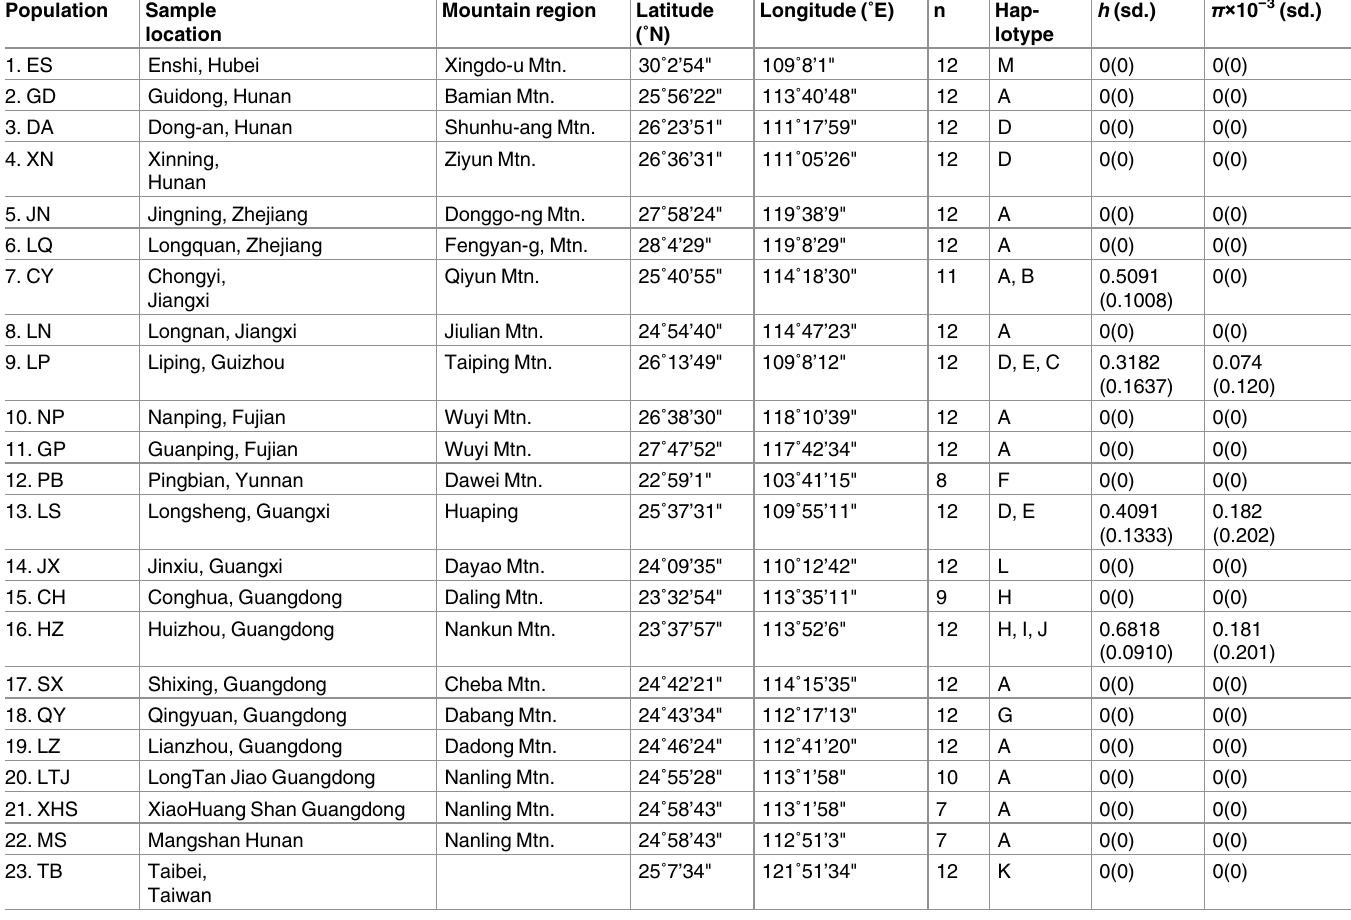
Table 1. Sampling sites, sample sizes (n), haplotype diversity ( h ), and nucleotide diversity ( π ) of the 23 Bretschneidera sinensis populations investigated in this study. Standarderrors are given in